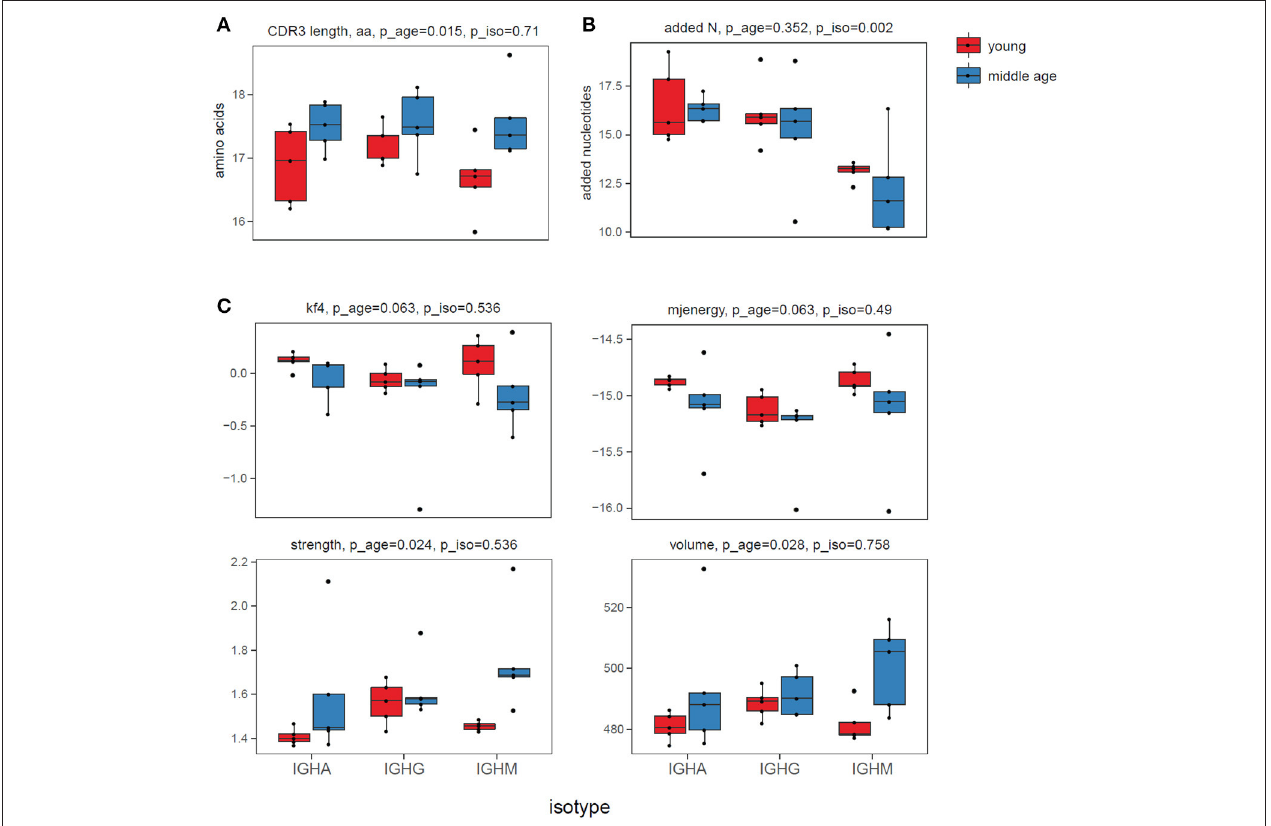
FIGURE 1 | CDR3 characteristics. (A) CDR3 length, aa. (B) Number of non-template added N nucleotides within V-D-J junction. (C) Physicochemical properties for the 5 amino acids residues in the middle of CDR3: Kidera factor 4 (hydrophobicity, lower values refer to more hydrophobic amino acids), potential “energy” of interaction (49) (lower values refer to stronger interaction), “strength” and “volume.” All characteristics were calculated “weighted”—i.e., accounting for IGH clonotype size. ANOVA p -values for age and for isotype adjusted using Benjamini & Hochberg correction are shown on top of each plot.